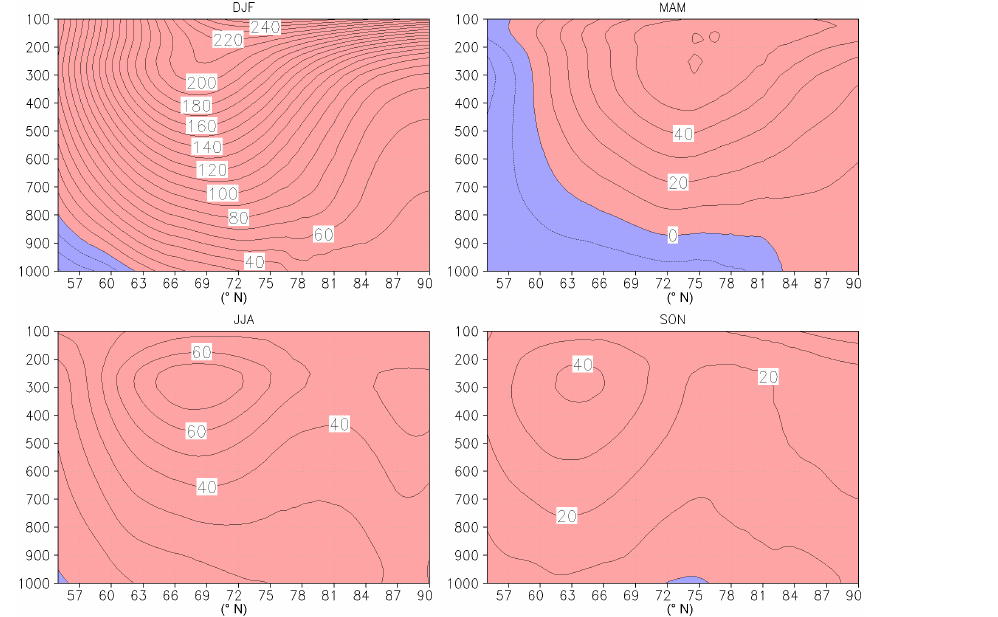
Figure 4. Differences in the mean geopotential heights between mild and cold winters along the 60 ◦ W vertical slice. Contour intervals are 10gpm; blue represents negative height differences and red positive height differences.